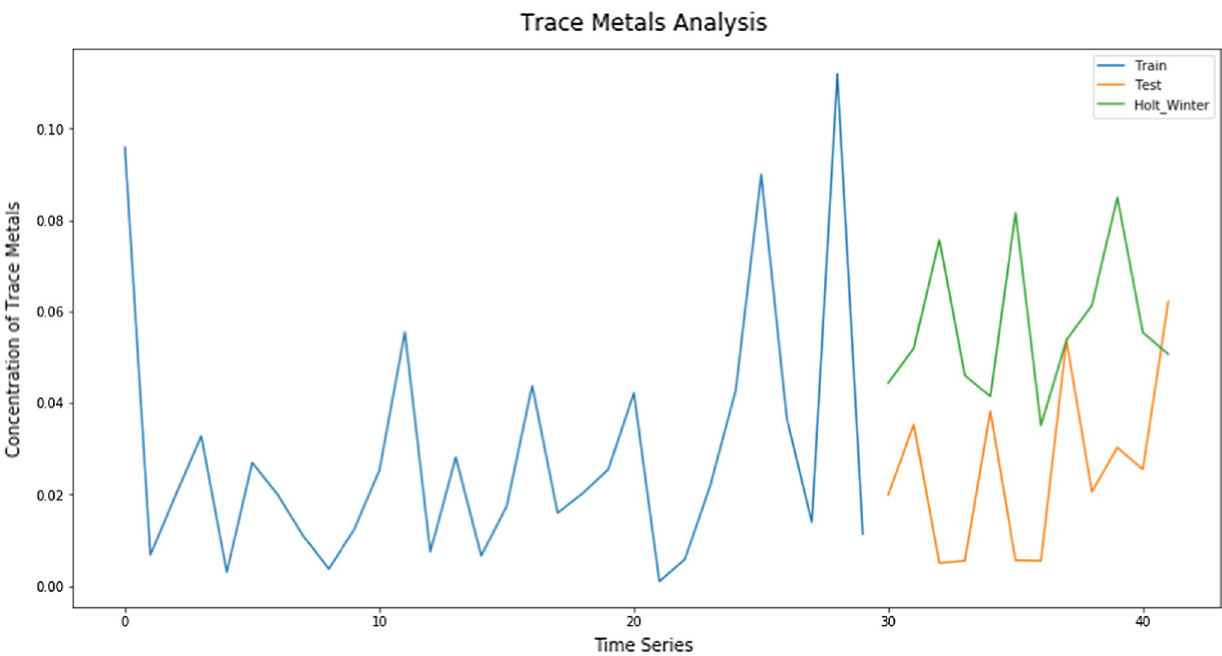
Fig. 10 Trace metals prediction using Holt winter (machine learning with Python)